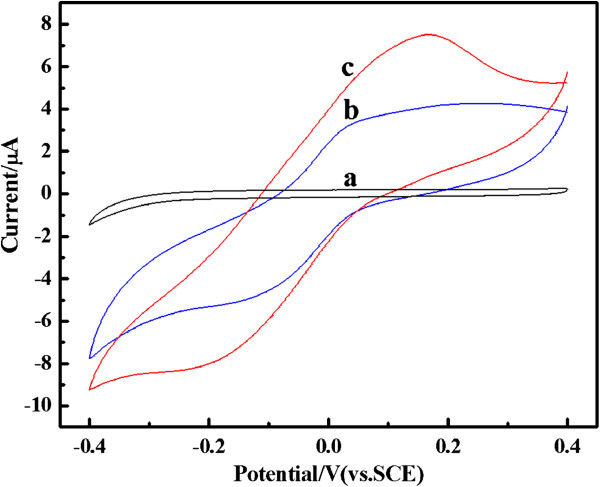
CV curves of bare GCE and PANI(HAuCl4·4H2O)/GCE. GCE (curve a) and PANI(HAuCl4·4H2O)/GCE in 0.1 M PBS at pH 6.8 without (curve b) and with (curve c)10 mM H2O2. Scan rate is 50 mV s−1.